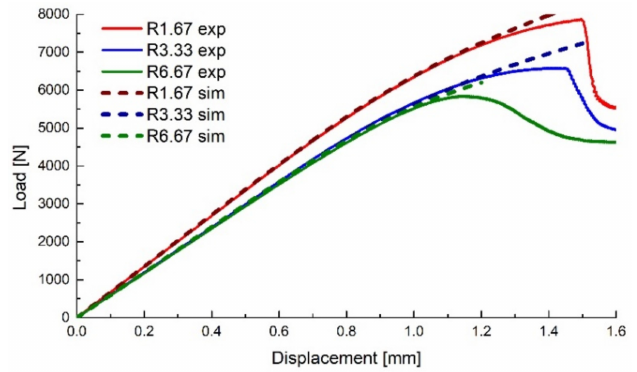
Figure 10. Experimental data compared with numerical results for the upsetting